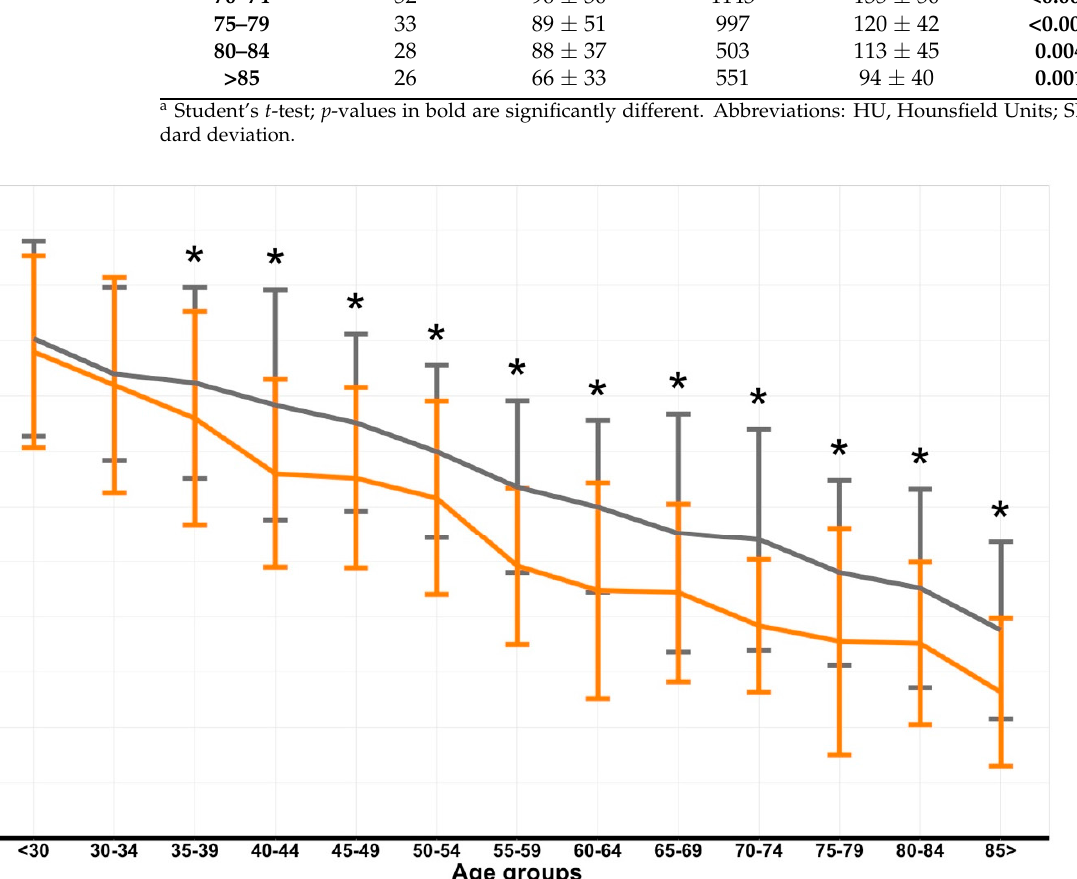
taken when using extrapolated North American values as thresholds for